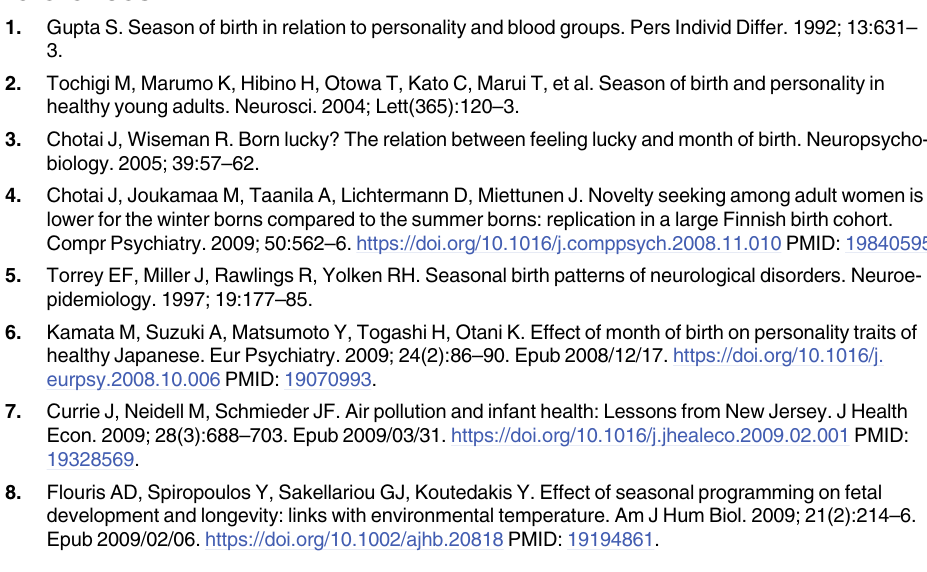
S1 Table. The mean differences between TCI NS subdimensions and seasons in